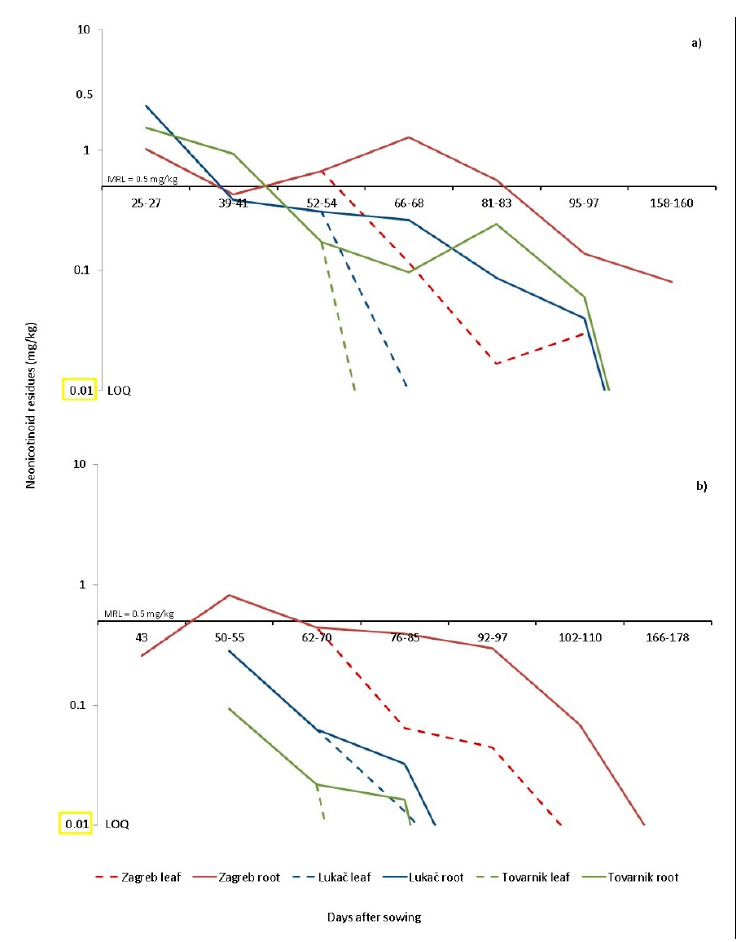
Figure 1. Degradation dynamics of imidacloprid during the growing seasons 2015 ( a ) and 2016 ( b ) in sugar beet plants in Lukac, Tovarnik and in greenhouse trials, in compliance with the maximum permitted residue level of 0.5 mg/kg; LOQ — limit of quantification; MRL — maximum residue level.